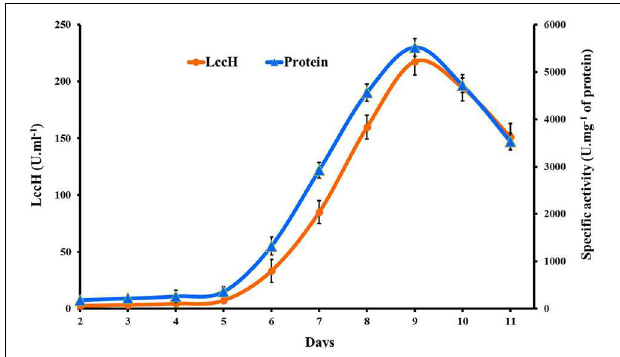
FIGURE 2 | Time course of volumetric and specific activity of laccase production by H.hirta . Error bars represent standard deviations of triplicate experiments.